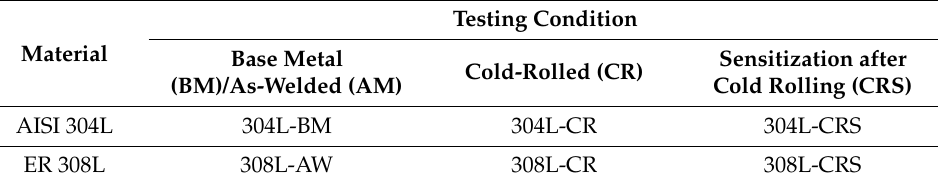
Table 2. Test matrix of the current